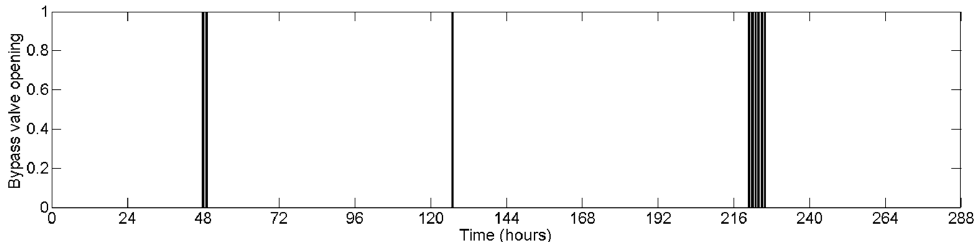
Figure 10. Operational scheduling for the bypass valve of the single NC 150–200 turbine installed at location 4.